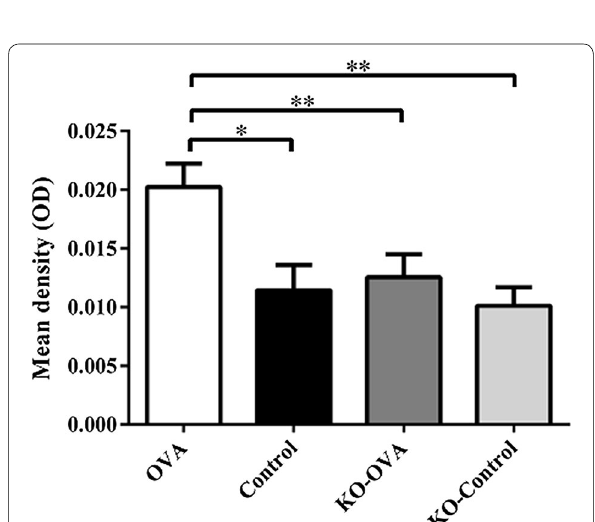
Fig. 6 Expression of BrdU measured by immunohistochemistry wild type and IL-25 KO mouse models that were sensitized and challenged with OVA or PBS (control) (*p < 0.05, **p < 0.01 and ***p < 0.001, n =